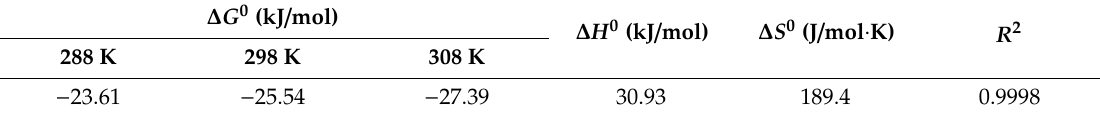
Table 3. Adsorption thermodynamics parameters of Hg(II) by the biopolymer.